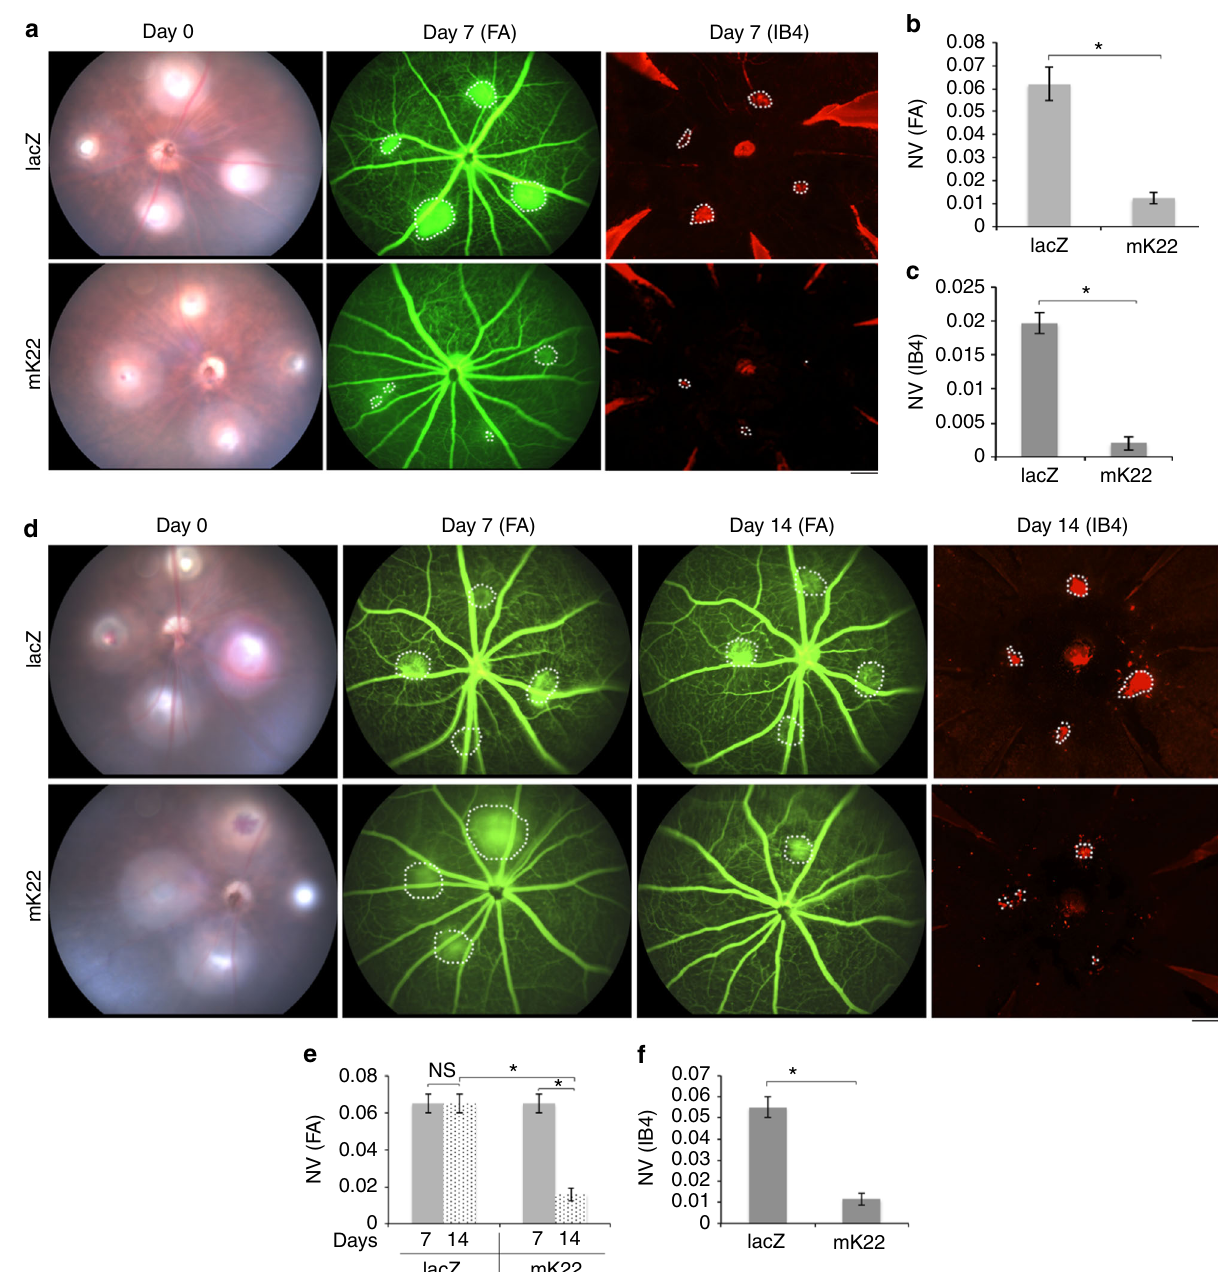
Fig. 4 AAV-CRISPR/Cas9-targeting genomic VEGFR2 suppressed NV in laser-induced choroid NV in mice. After laser injury of Bruch ’ s membrane, fundus images (day 0) were taken using the Micron III system, and the mice were injected intravitreally with 1 μ l (3.75× 10 12 vg/ml) containing equal rAAV1- SpCas9 and rAAV1-lacZ or -mK22 right immediately after the laser injury ( a ) or 7 days of the laser injury ( d ). Seven days after AAV1 injection, the mice were injected intraperitoneally with fl uorescein, and the FA images were taken using the Micron III system. Subsequently, whole mounts of choroids were stained with IB4, and the images were taken under an immuno fl uorescence microscope. Areas of NV were analyzed based on the images of FA ( b , e ) and IB staining ( c , f ) ( n = 6). “ * ” indicates signi fi cant difference between the compare two groups using an unpaired t -test. p < individually or both of rAAV1-SpCas9 with rAAV1-mK22 or rAAV1-lacZ (2 μ l/ well for each rAAV1, 3.75 ×10 12 viral genome-containing particles (vg)/ml). Three days later, the cells were photographed under an immuno fl uorescence microscope for determining the rAAV1 transduction ef fi ciency. After 4 days, the cells were lysed with 1× sample buffer for western blotting analysis or collected for genomic DNA isolation. Western blot . Cells were lysed in 1× sample buffer, which was diluted with extraction buffer (10 mM Tris-HCl, pH 7.4, 5 mM EDTA, 50mM NaCl, 50mM NaF, 1% Triton X-100, 20 μ g/ml aprotinin, 2mM Na 3 VO 4 , and 1 mM phe- nylmethylsulfonyl fl uoride) from the 5× protein sample buffer (25 mM EDTA (pH